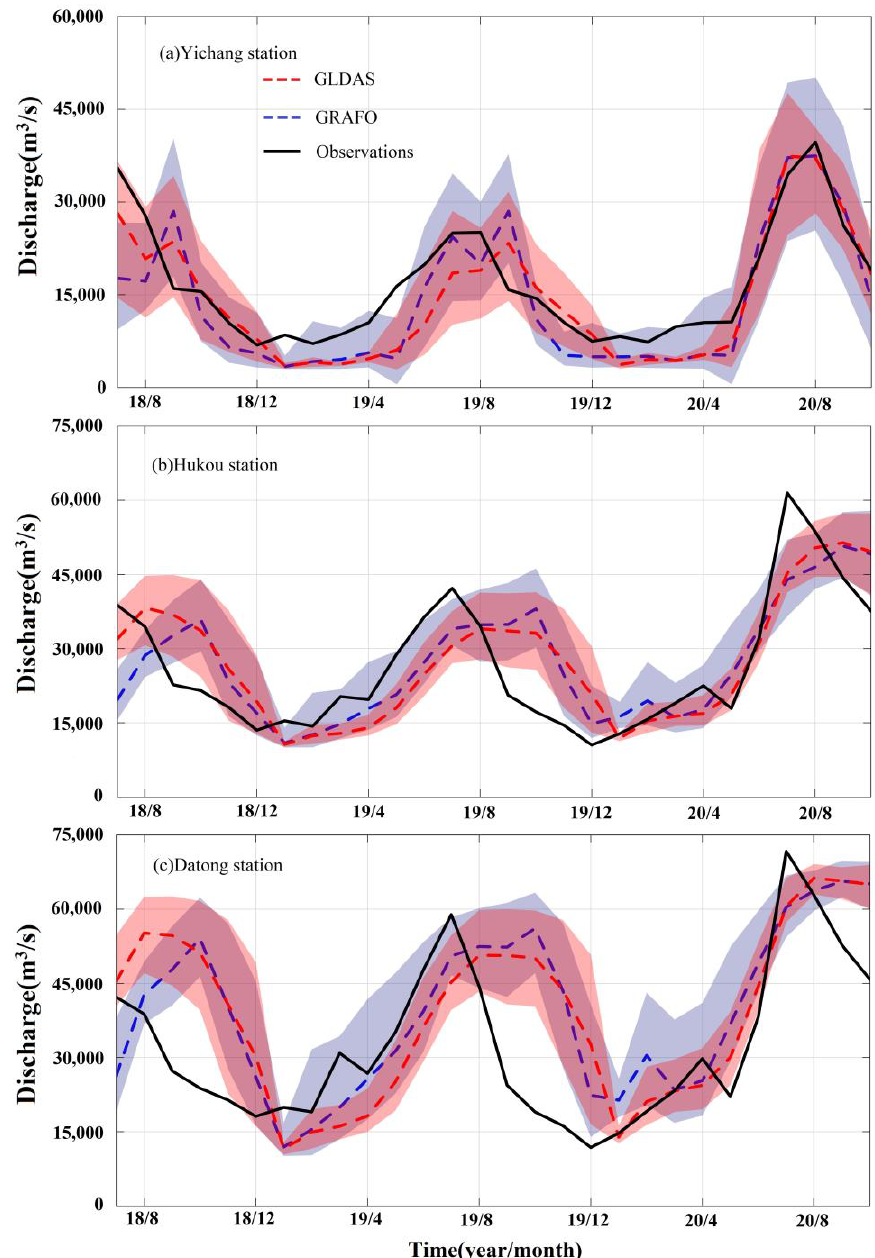
Figure 7. Ensemble means of GRAFO-derived, GLDAS-modeled, and observed discharge at the (a) Yichang, (b) Hukou, and (c) Datong gauge station between July 2018 and October 2020, on which the shading area is the change range of runoff data.